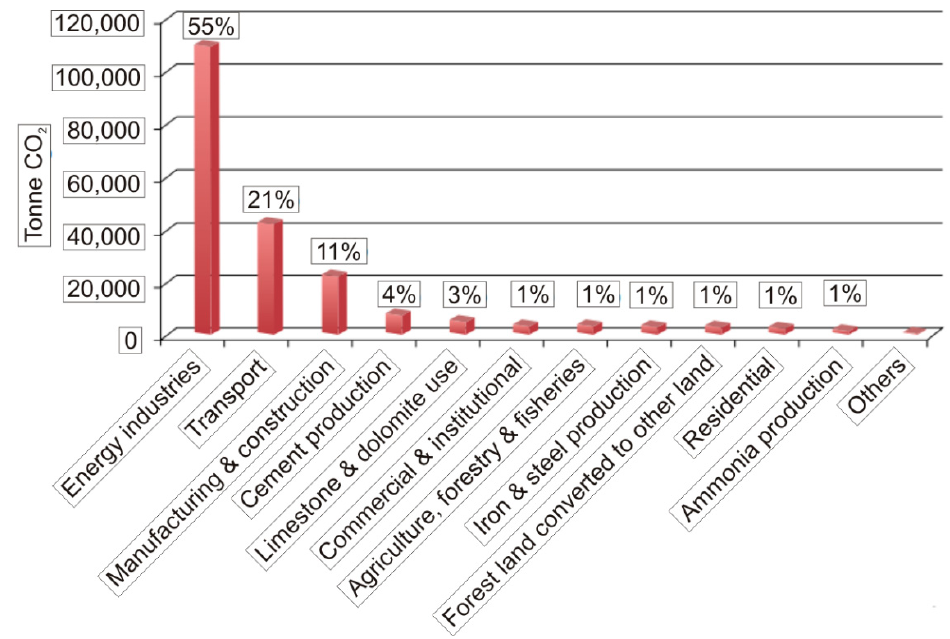
Figure 1. Sectors contributing to CO 2 emissions in Malaysia [22].